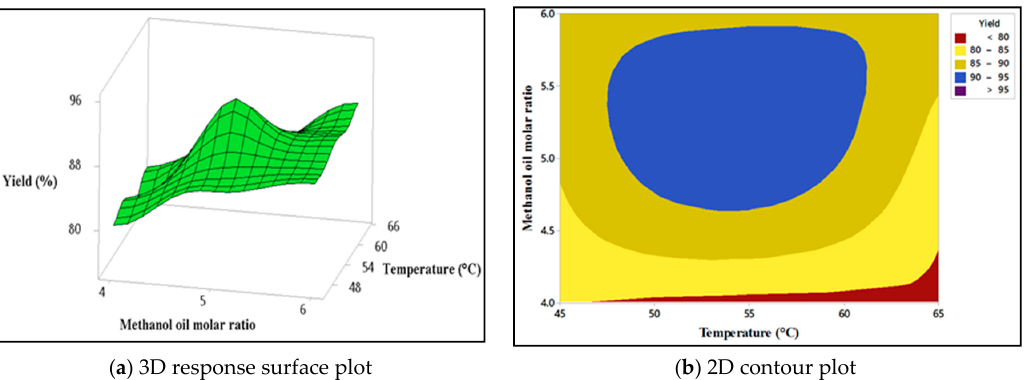
Figure 8. Interaction effect of methanol: oil molar ratio (M) and reaction temperature (T) on SFO biodiesel yield.